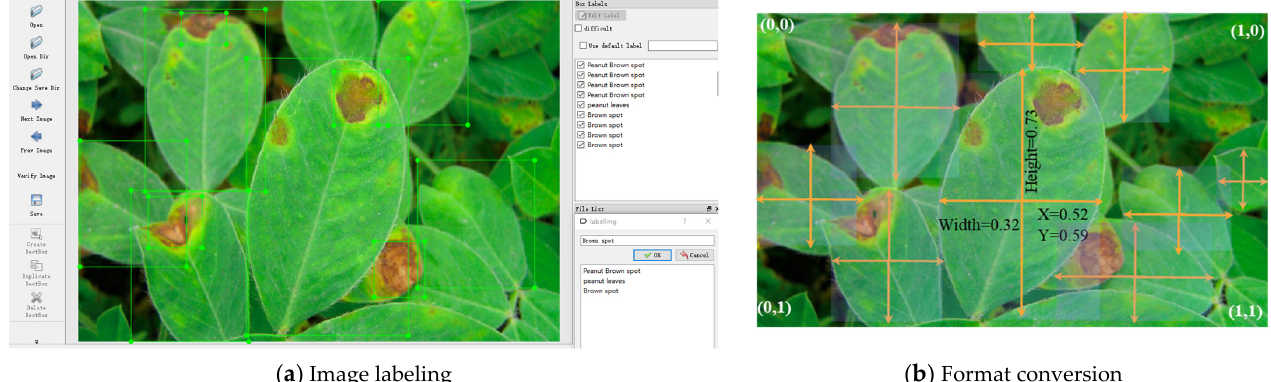
Figure 2. Example of image labeling ( a ) and format conversion ( b